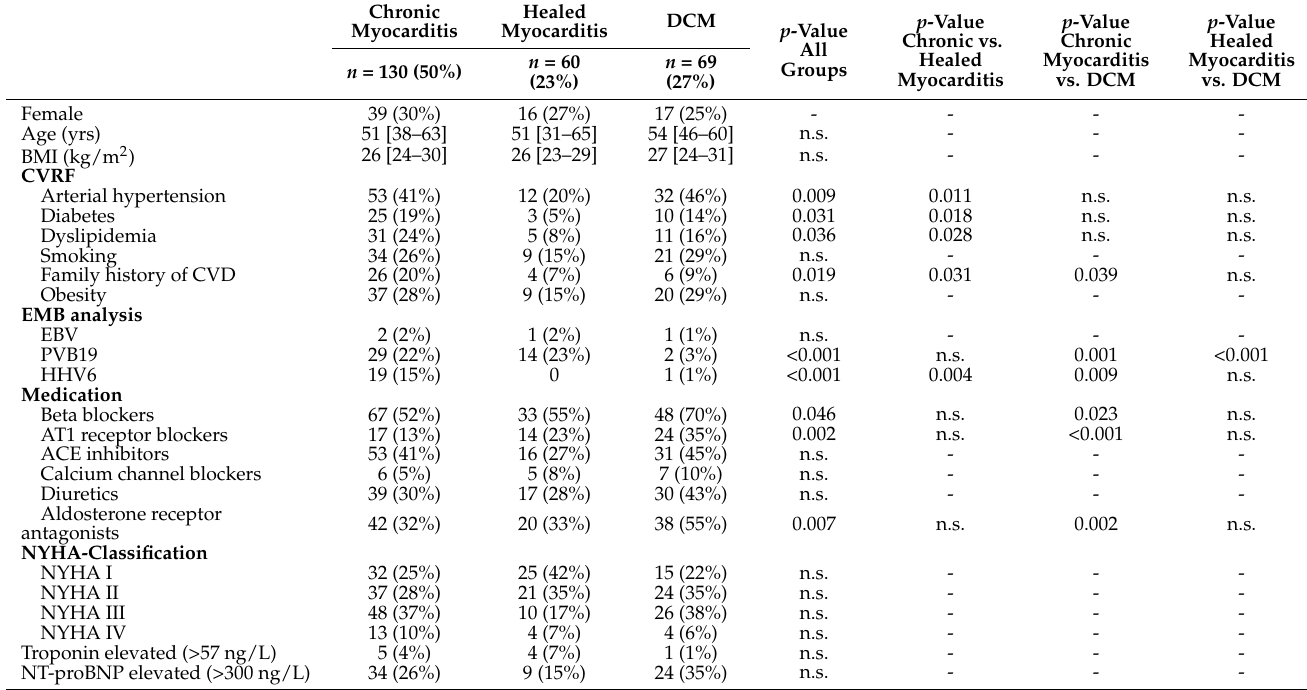
Table 1. Patient Characteristics.